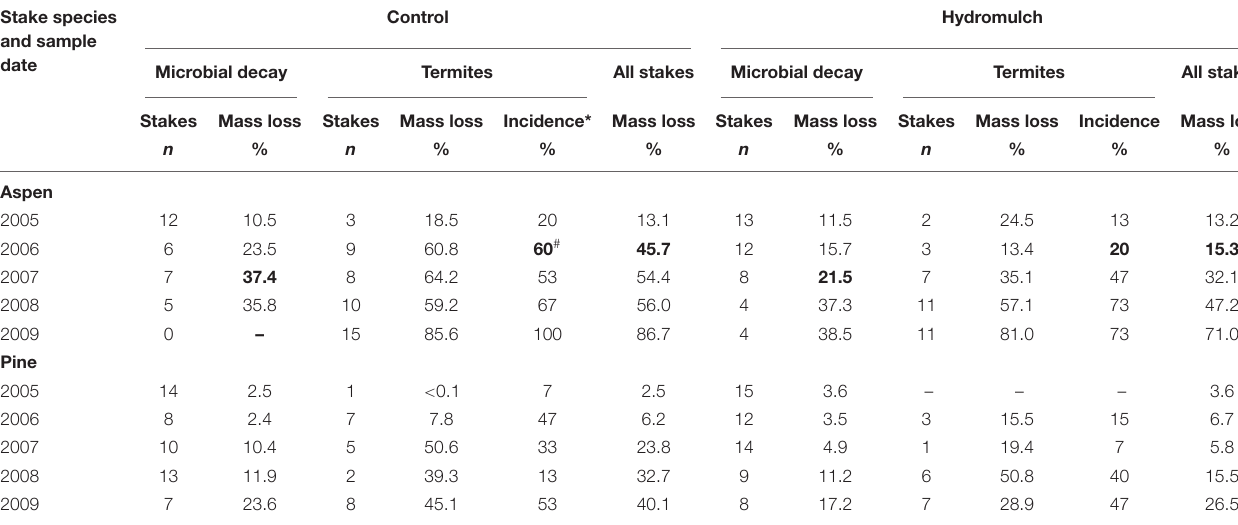
TABLE 3 | Mass loss of aspen and pine stakes from microbial decay and termites in mineral soil following a hydromulch application after the Cedar Fire near Alpine, California. Stake species and sample